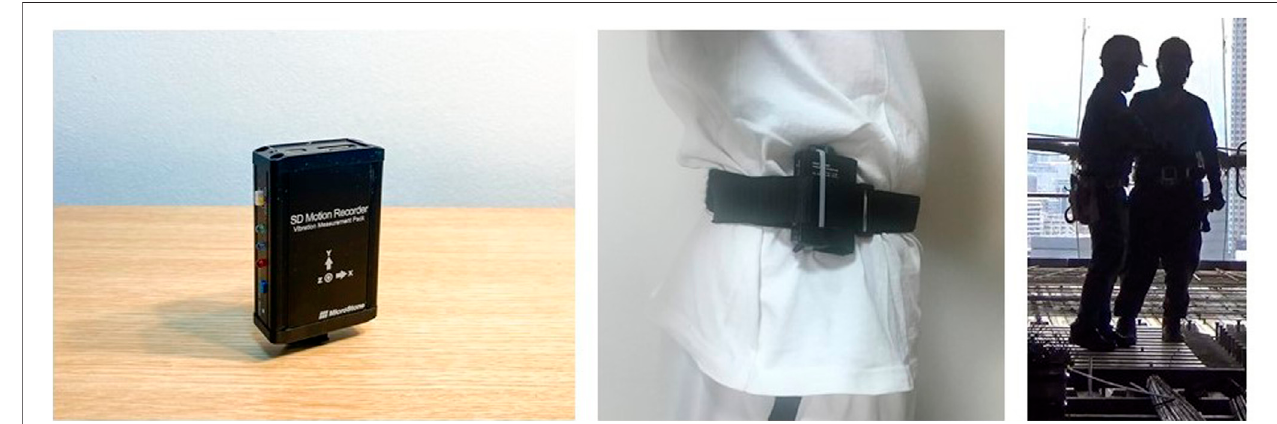
FIGURE 1 | Accelerometer (Left: Accelerometer, Center: Location, Right: Rebar